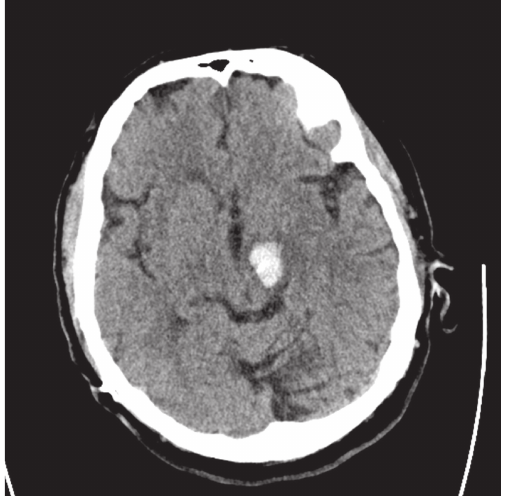
F 3: Axial CT without contrast enhancement